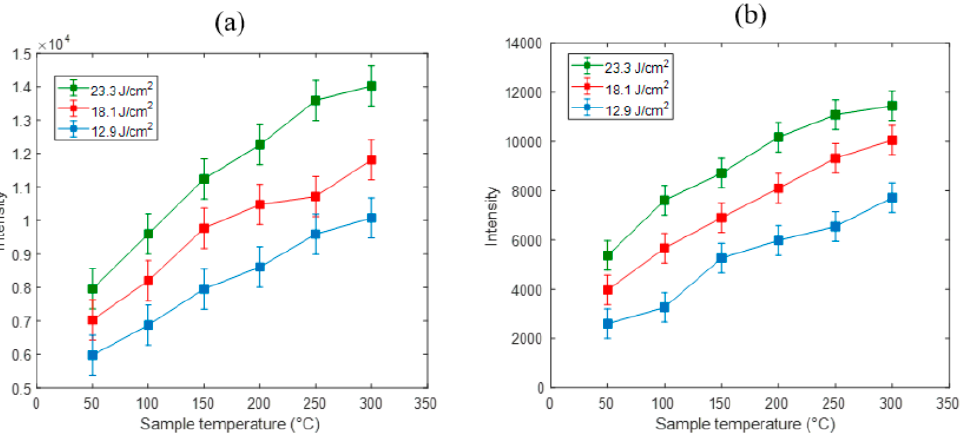
Figure 5. ( a ) Emission intensity of Mg I-518.4 nm with sample temperatures for di ff erent laser fluences at a delay time of 15 µ s. ( b ) Emission intensity of Ti II–376.2 nm with sample temperatures for di ff erent laser fluences at a delay time of 15 µ Figure 6. ( a ) Time-resolved emission line of Mg I-518.4 nm for different sample temperatures of 100, 200 and 300 °C at at laser fluence of 18.1 J cm −2 . ( b ) Time-resolved emission line of Ti II – 376.2 nm for different sample temperatures of 100, 200 and 300 °C at laser fluence of 18.1 J cm −2 .